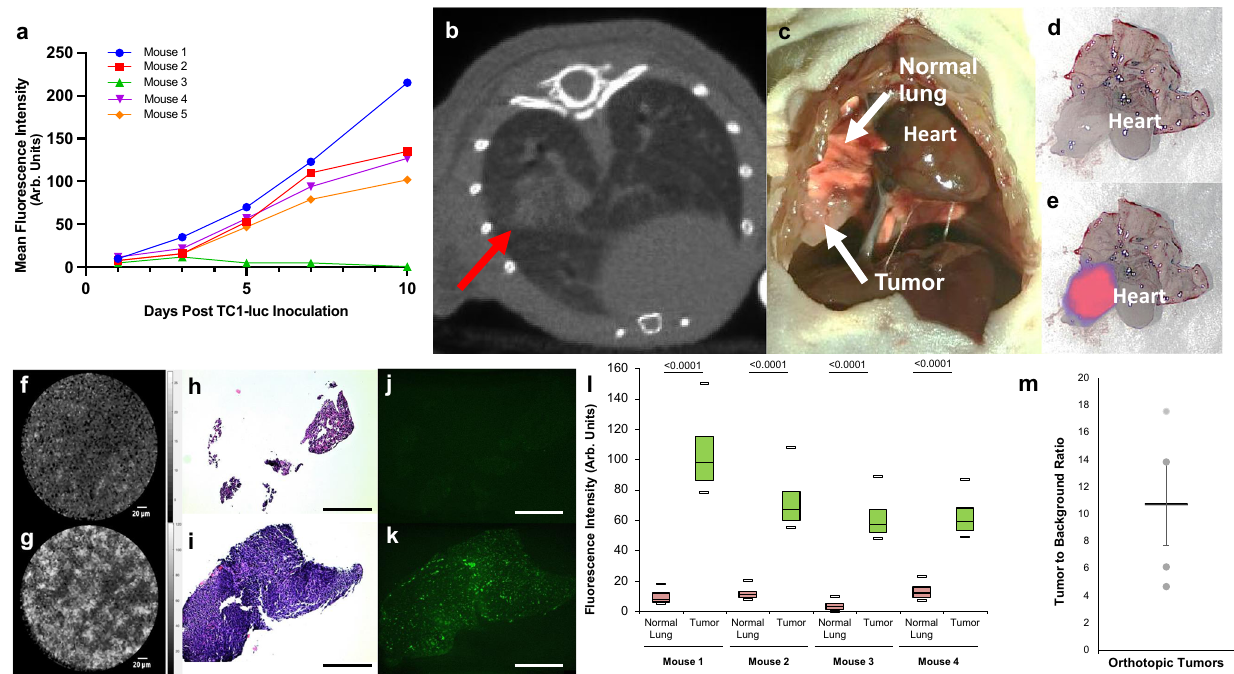
Fig. 3 NIR-nCLE distinguishes tumor from normal lung in an orthotopic murine model. a Growth of orthotopic murine lung adenocarcinoma (TC1-luc) tumors as assessed using bioluminescence imaging with a NIR luciferin analog. b Respiratory gated CT image of a representative tumor at 10 days, with red arrow marking the tumor. c , d White light images of an orthotopic tumor in situ and ex vivo 24 h after infusion with pafolacianine (2 mg/kg). Animals were killed prior to thoracic cavity exposure, organ harvest, and image acquisition. e NIR image of the orthotopic tumor showing clear macroscopic fl uorescent signal. f , g Representative NIR-nCLE images of normal and tumor tissue, respectively. h , i Hematoxylin and eosin-stained slides of biopsies taken from the site of NIR-nCLE imaging. Scale bars represent 5 mm. j , k Fluorescence microscopy of biopsy slides from normal lung and tumor tissue, respectively. Scale bars represent 5 mm. l Mean fl uorescence intensity (MFI) of NIR-nCLE sequences taken during biopsy of normal lung and tumor tissue for each mouse. Minima, center, and maxima of boxes represent 25th percentile, mean, and 75th percentile of MFI obtained for the entire imaging sequence. ( n = 117, 117, 117, and 118 frames for normal lung biopsies for Mice 1, 2, 3, and 4, respectively; n = 116, 111, 110. And 117 frames for tumor biopsies for Mice 1, 2, 3, and 4, respectively). Whiskers represent the 5th and 95th percentile of MFI over the same sequence. Statistical comparisons were performed using two-sided t tests and p values are shown on the graph. m Tumor-to-background ratios of the orthotopic TC1-luc tumors ( n = 4 biologically independent animals). Each tumor is represented by a single point, with mean line and standard error bars also